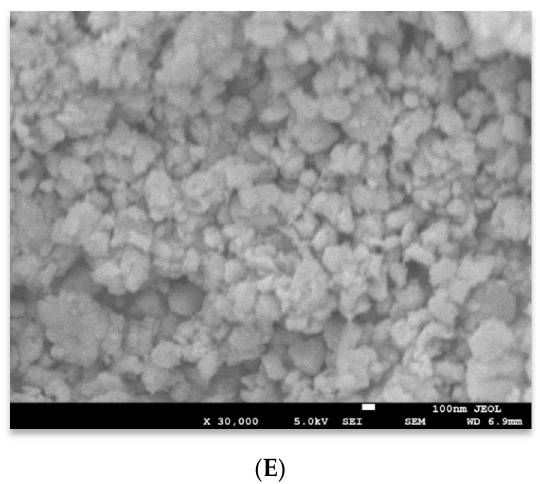
Figure 2. SEM images of ( A ) pure and Al doped ZnO NSs, ( B ) 0.5 mol %, ( C ) 1 mol %, ( D ) 2 mol %, and ( E ) 3 mol %.